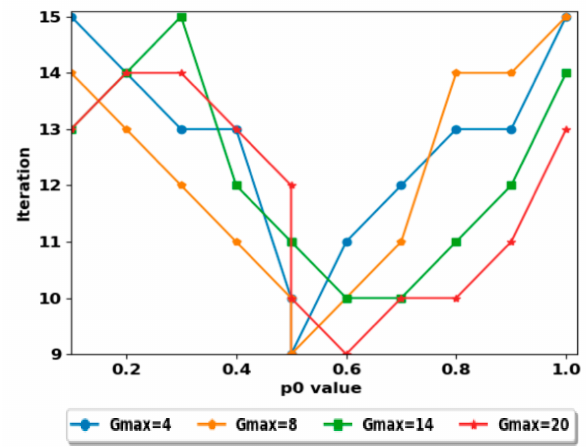
Figure 6. The number of iterations to obtain AC according to p0